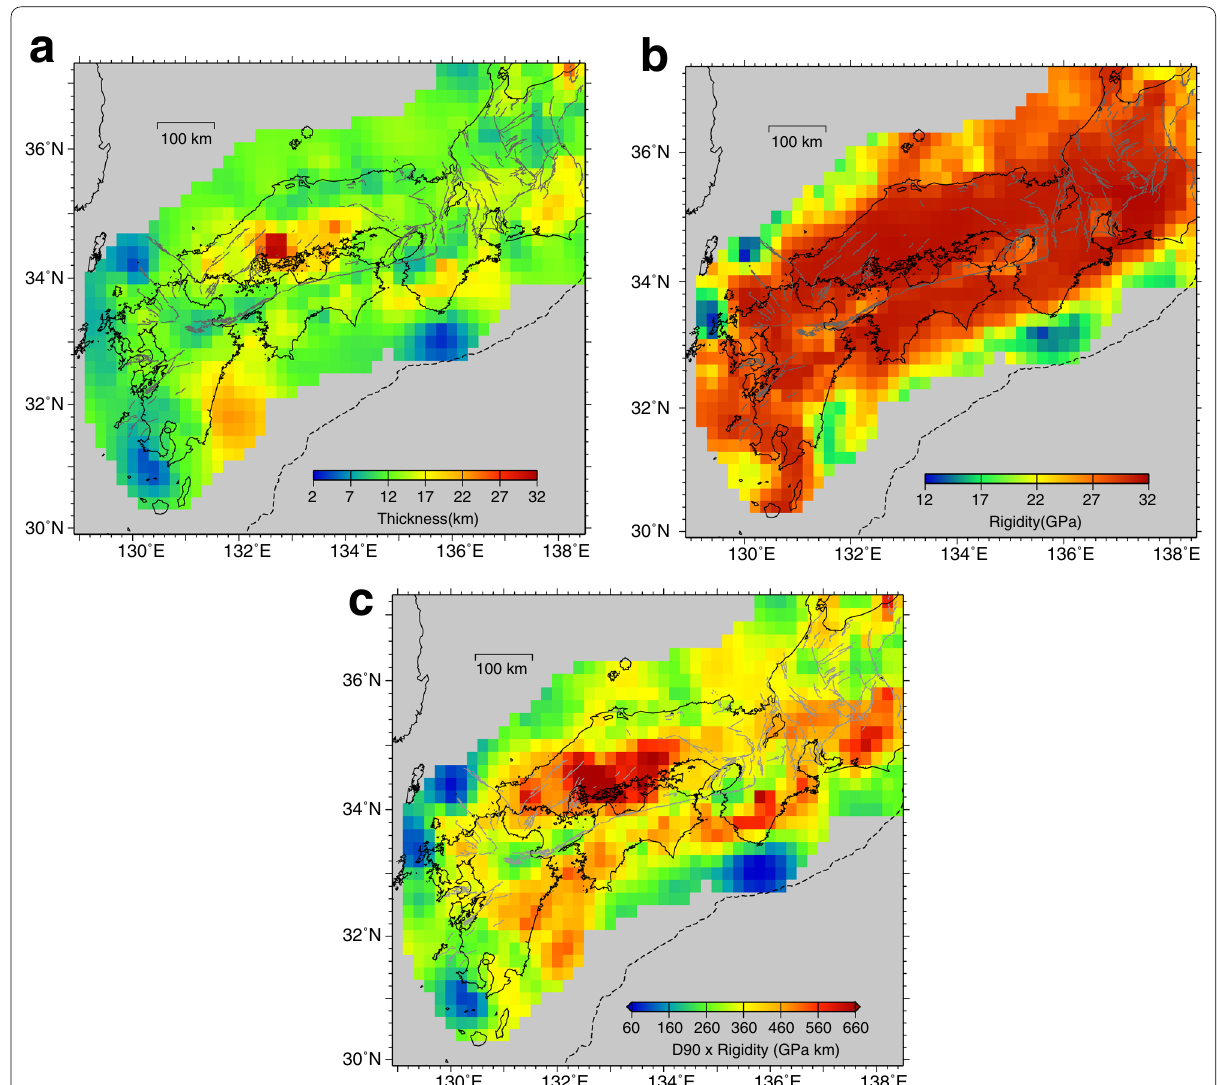
Fig. 2 Seismogenic layer thickness and rigidity distribution used in the conversion to seismic moment rates. Gray lines indicate major active faults (HERP, 2021). a Thickness of the seismogenic layer derived from D90, the depth above which 90% of earthquakes occur (Omuralieva et al. 2012). b Average rigidity in the elastic thickness calculated from the deep subsurface structure model of J-SHIS (https:// www.j- shis. bosai. go. jp/ en/). c Product of elastic thickness and average